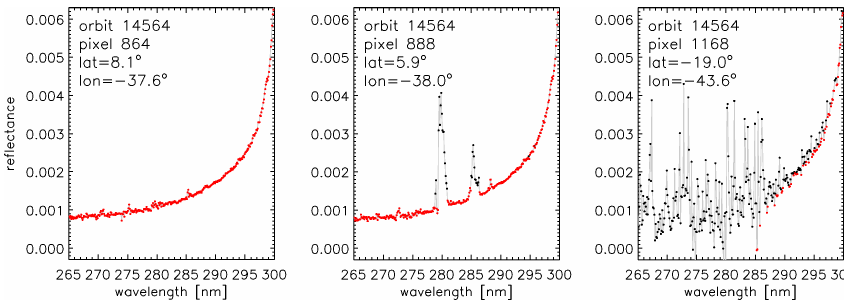
Fig. 3. Reflectance measurements in Band 1a for a typical measurement outside the SAA (left), on the edge of the SAA (middle), and in the centre (right). Measurements which pass the filter are indicated by the red dots. Spikes and noisy parts of the measurements are blocked by the